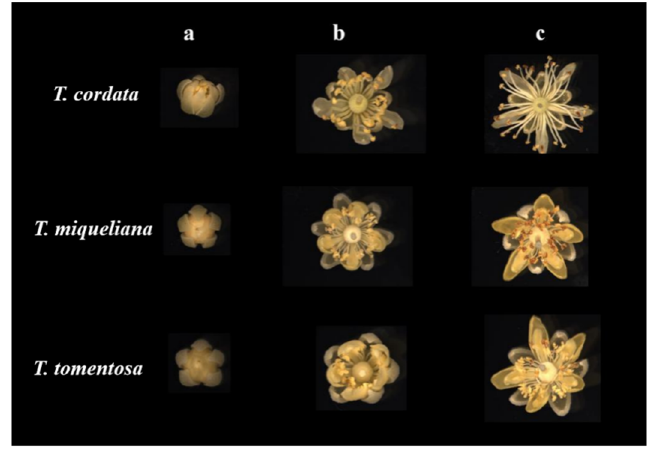
Figure 1. Flowers of the three species from Tilia at different flowering stages: bud stage ( a ), half-open stage ( b ), and blooming stage ( c